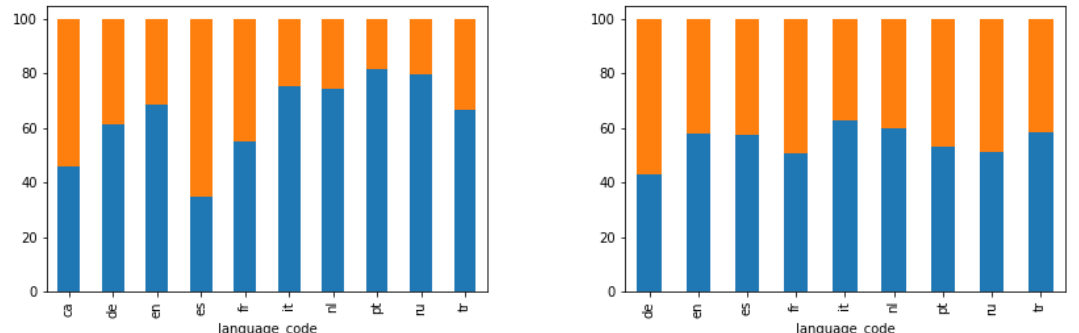
Figure 8. Distribution of the top 10 languages for Valencia ( left ) and Berlin ( right